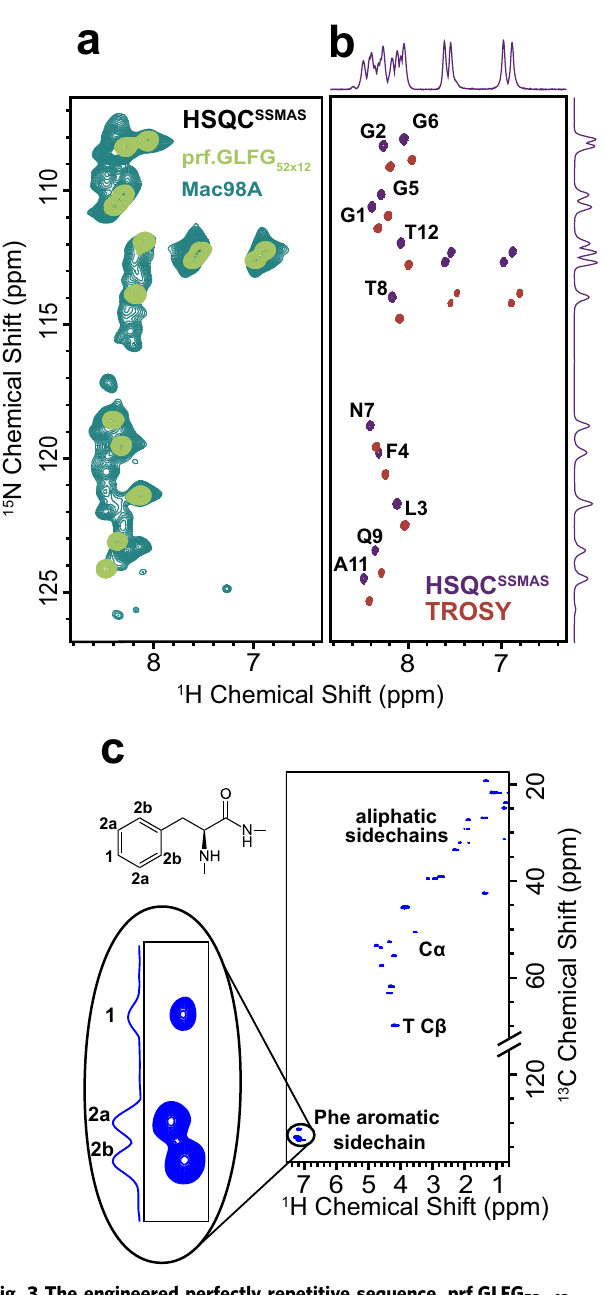
Fig. 3 The engineered perfectly repetitive sequence, prf.GLFG 52×12 improves the resolution of NMR measurements. a Overlay of 15 N- 1 H correlation spectra ( 15 N- 1 H HSQC SSMAS ) of phase-separated Mac98A FG domain (forest green) and prf.GLFG 52×12 (light green), where each peak corresponds to an amide group with a distinct chemical environment. b 15 N- 1 H HSQC SSMAS of prf.GLFG 52×12 (purple) and the TROSY spectrum (red). The peak positions are shifted by half the 1 J( 15 N, 1 H) coupling in both dimensions as expected. Assignments of the prf.GLFG 52×12 are shown beside the peaks (also see Supplementary Fig. 4). Proline residues lack H N , and thus are not detected. c 13 C- 1 H HSQC SSMAS spectrum of prf.GLFG 52×12 . The cross peaks corresponding to CH bonds of the Phe aromatic sidechain are enlarged and labelled with their relative intensities